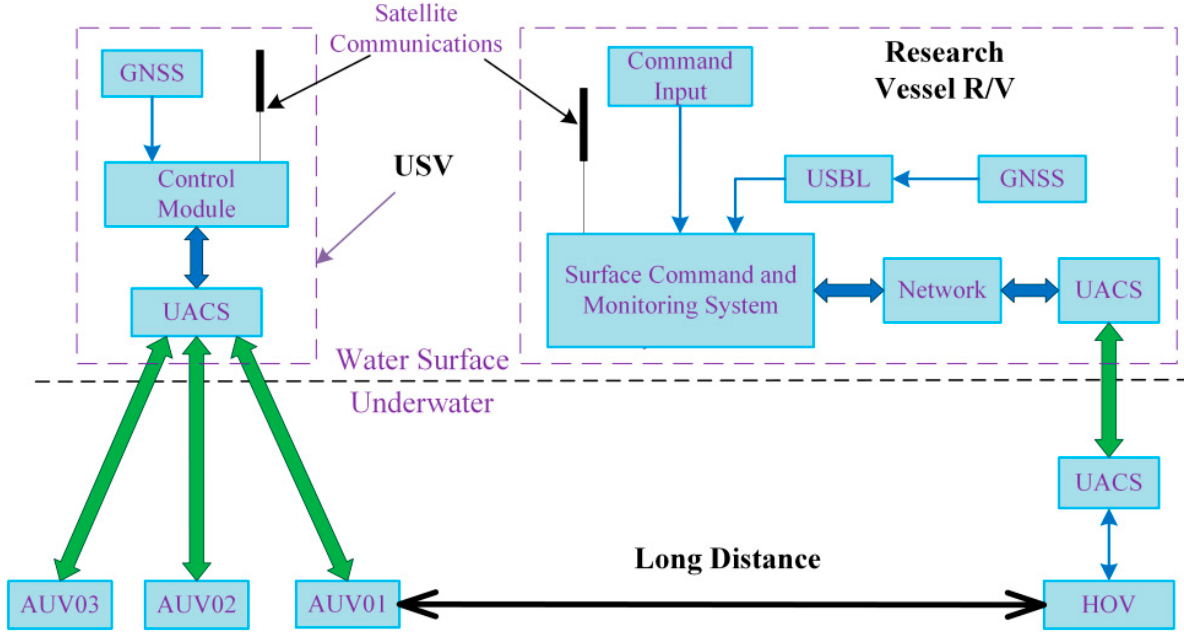
Figure 7. Information flow of a cooperative operation based on USVs.